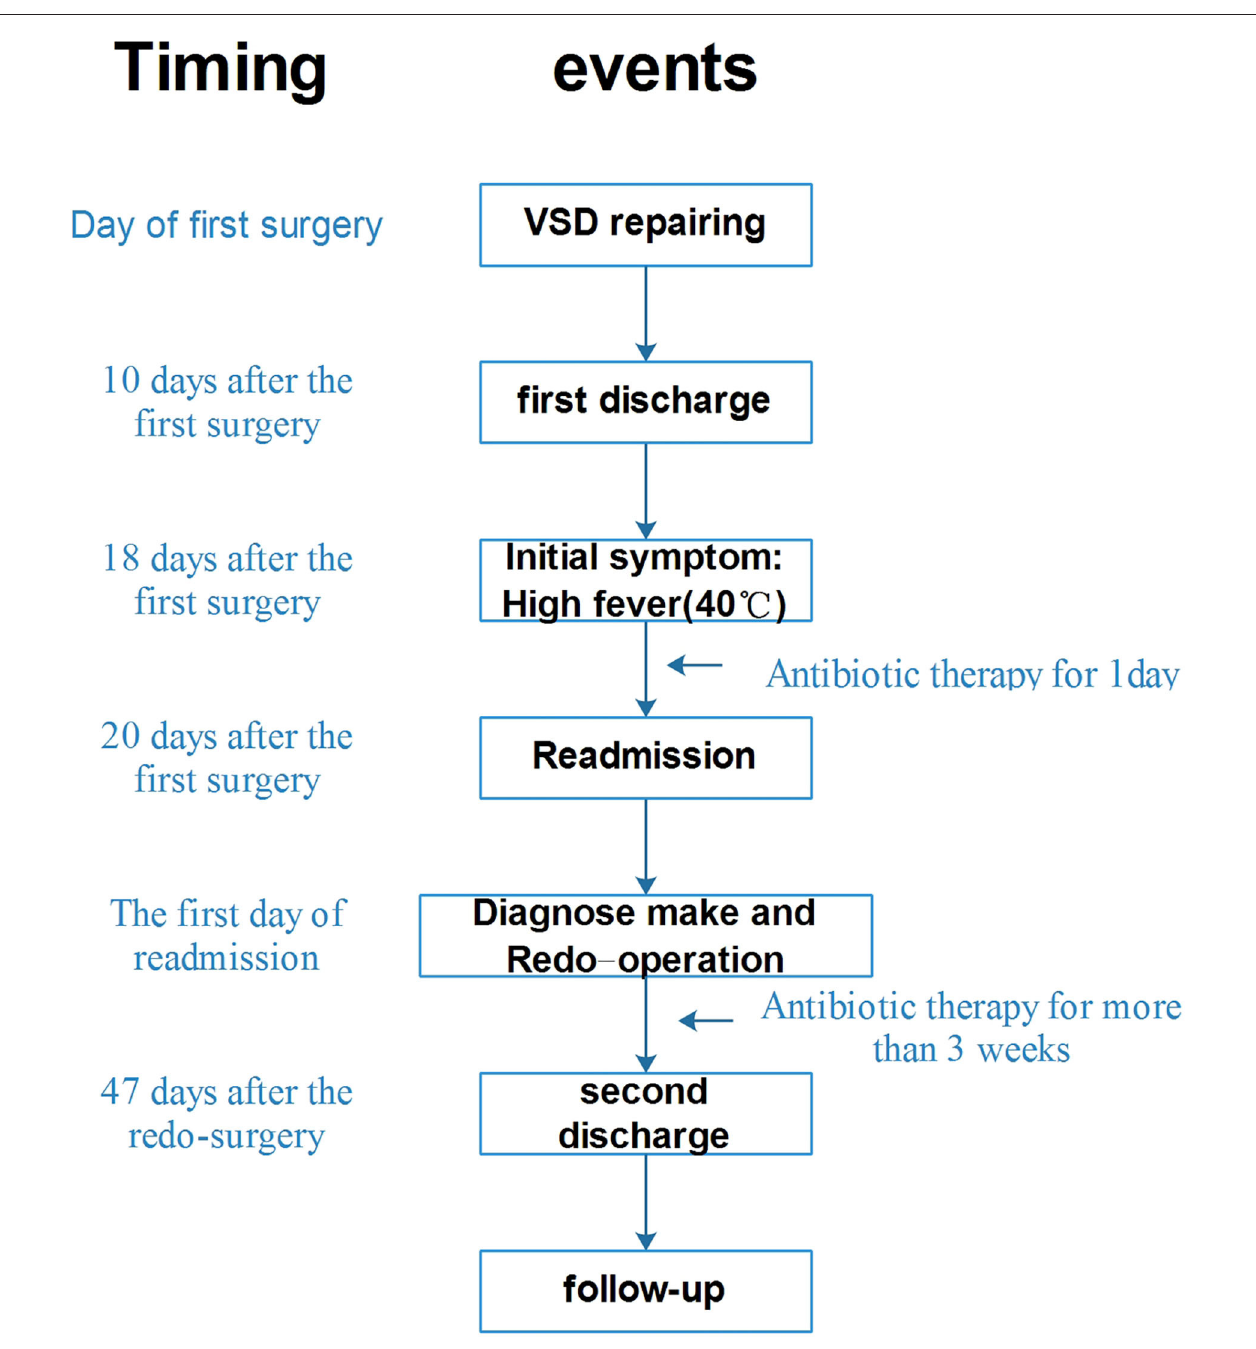
FIGURE 5 | A flow diagram shows the overall therapeutic